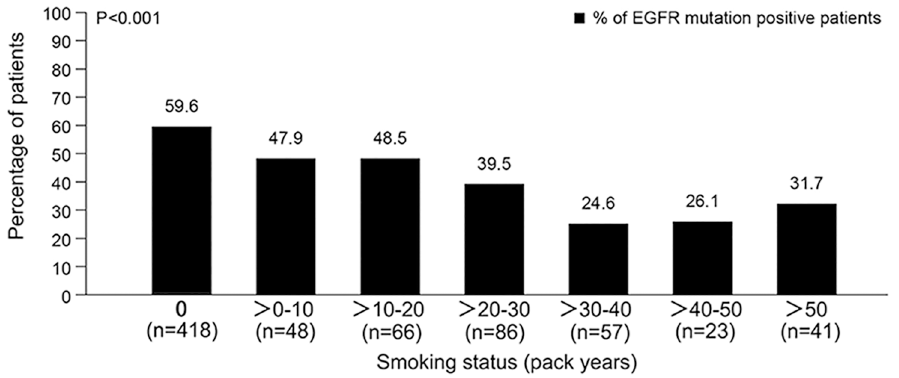
Fig 1. EGFR mutation frequency according to tobacco consumption (in